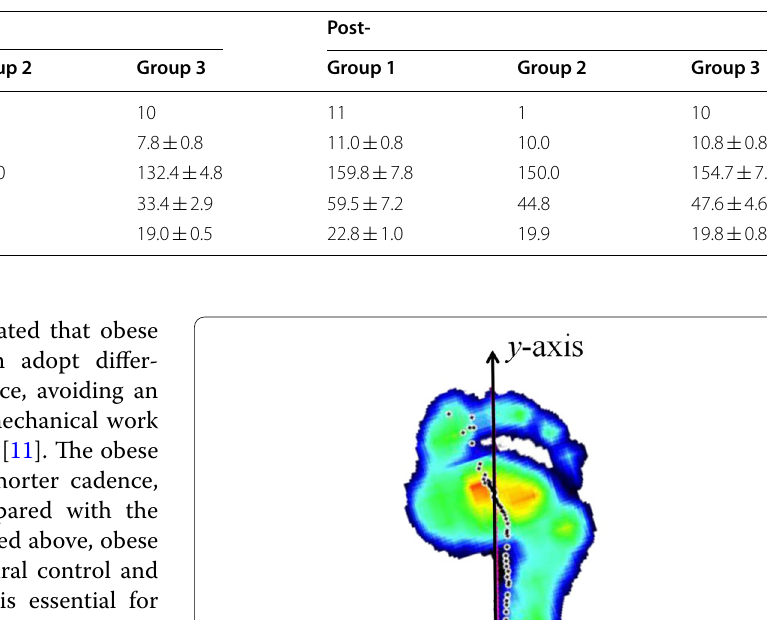
Table 2 Baseline data (Mean